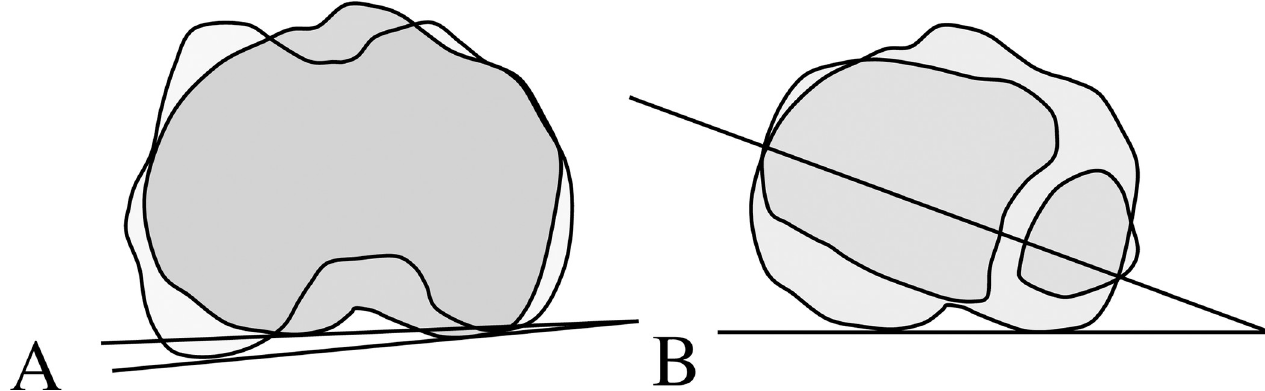
Fig 1. Diagram of torsional alignments measurement (A: tibiofemoral rotation, B: tibial torsion).